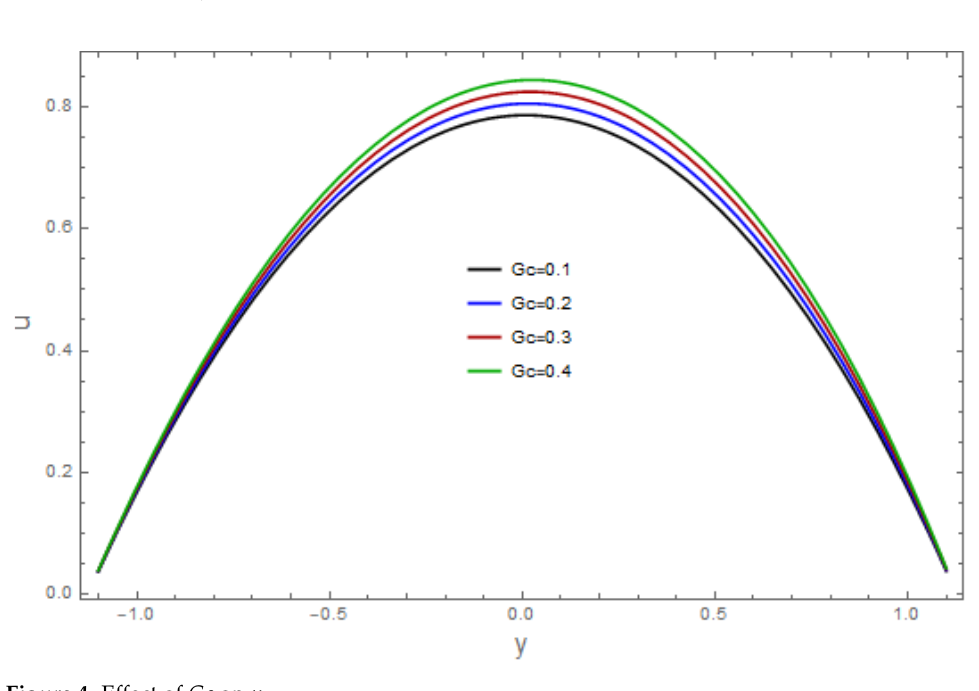
Figure 3. Effect of 𝐺𝑓 on 𝑢 .